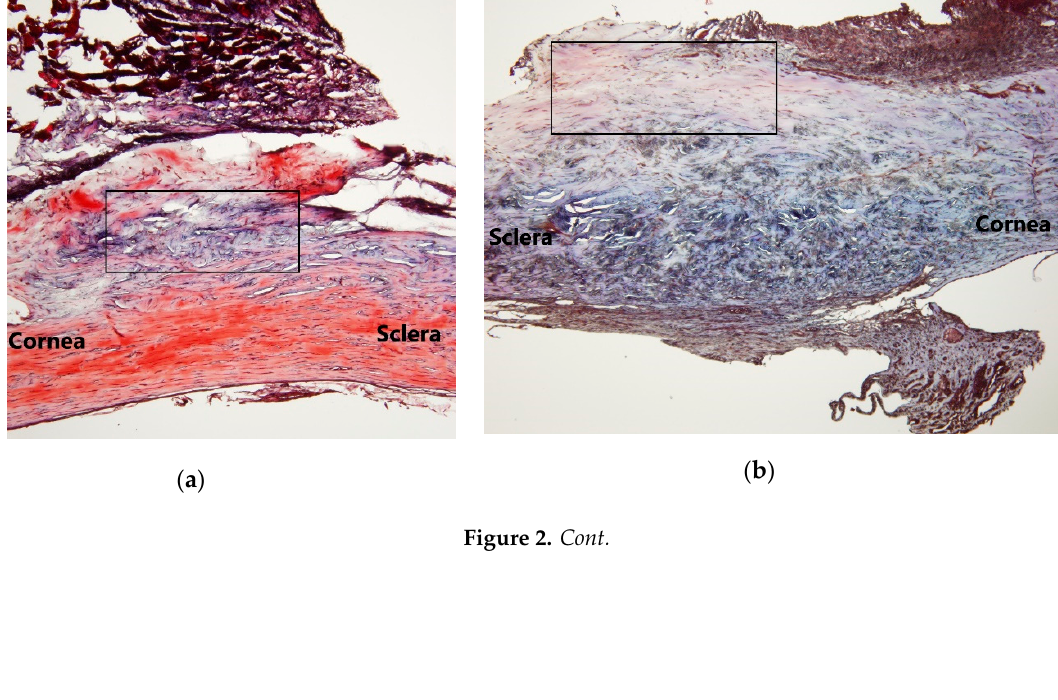
Figure 1. Effect of AR12286 on intraocular pressure (IOP) maintenance in rabbit models of trabeculectomy. IOP changes over entire experimental period are illustrated. Compared with IOP from the same rabbits prior to surgery (baseline), IOP levels in both groups were at lower levels throughout the entire experiment period. ∆ IOP is the di ff erence between IOP of surgical and nonsurgical eyes. ∆ IOP in AR12286 group rabbits (trabeculectomy with AR12286 treatment) exhibited significantly lower level at Days 1 ( p < 0.001), 2 ( p < 0.001), 6 ( p < 0.05), and 7 to 8 ( p < 0.05) than IOP from control group (trabeculectomy only). Asterisks indicate significantly di ff erent responses (*, p < 0.05; ***, p < 0.001).